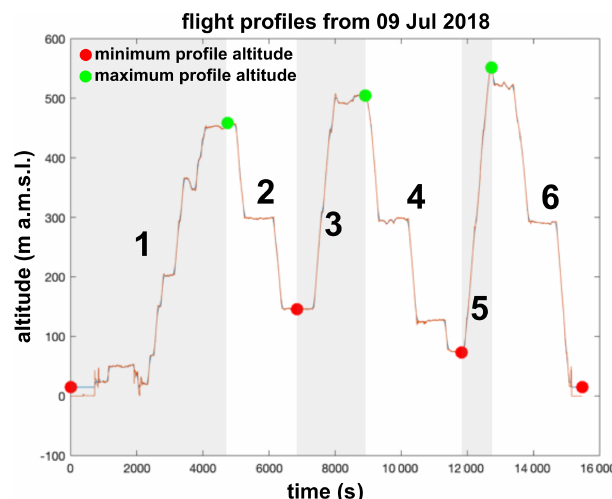
Figure 2. An example of how flight profiles are defined using the 9 July 2018 data. The red and green markers represent the minimum and maximum altitude of each profile, respectively, and thus define the start and end points of each profile. This example consisted of six profiles for the entire flight time